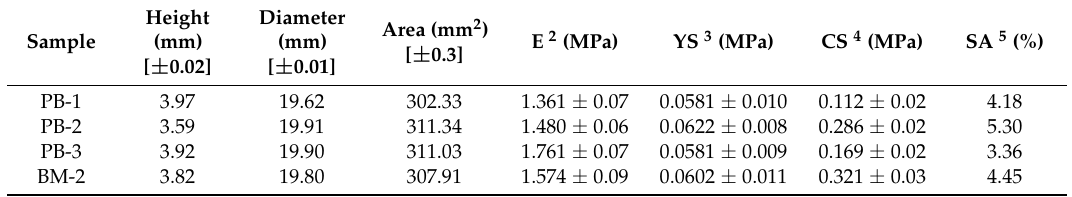
Table 2. Average values obtained in the mechanical compression tests on cylindrical specimens 1 .